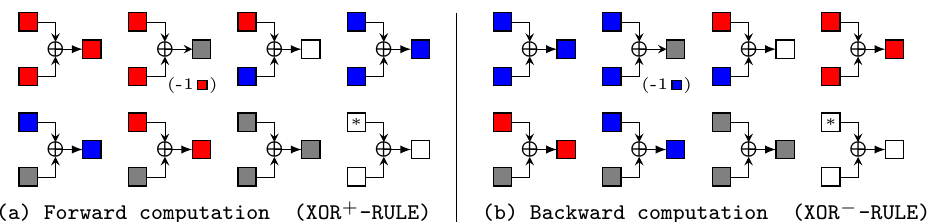
Figure 12: Rules for XOR ("*" represents the cell can be any color, "-1" means reducing the degrees of freedom by one) [BDG + 21]